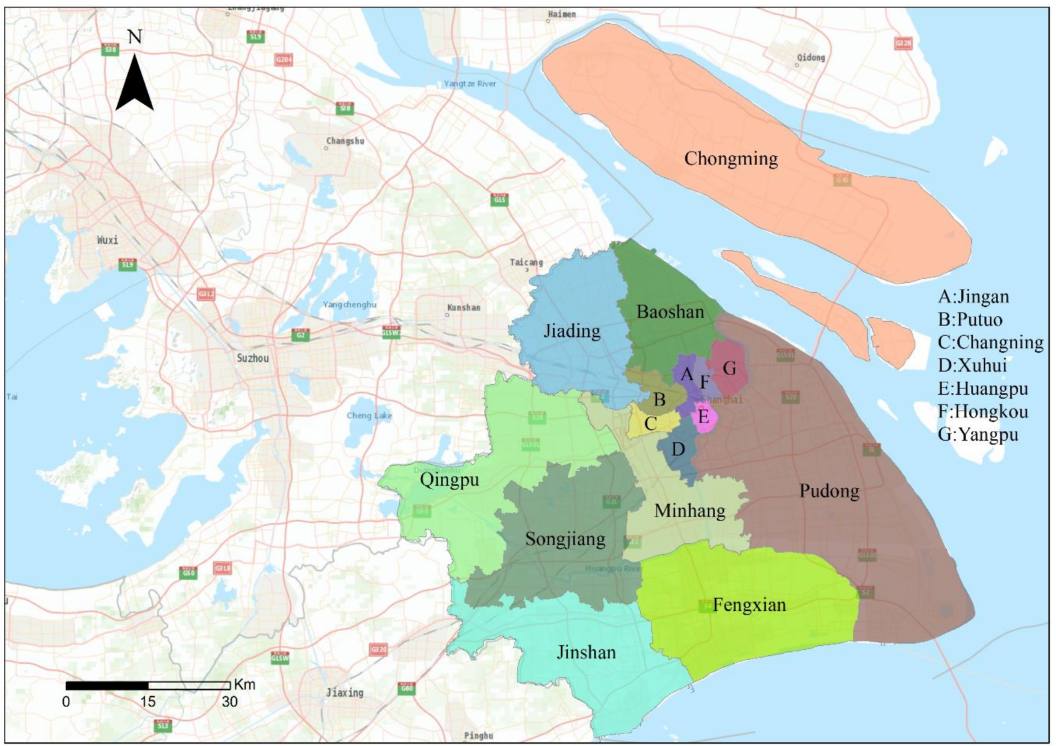
Figure 2. Geographical location of Shanghai city.